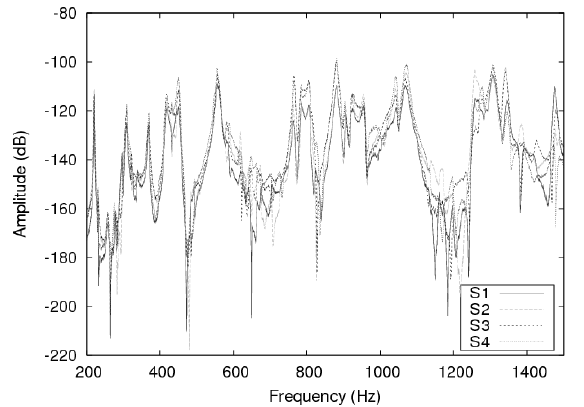
Fig. 2. FRFs at four sensors (S1, S2, S3, S4) for a particular measurement in the undamaged plate.